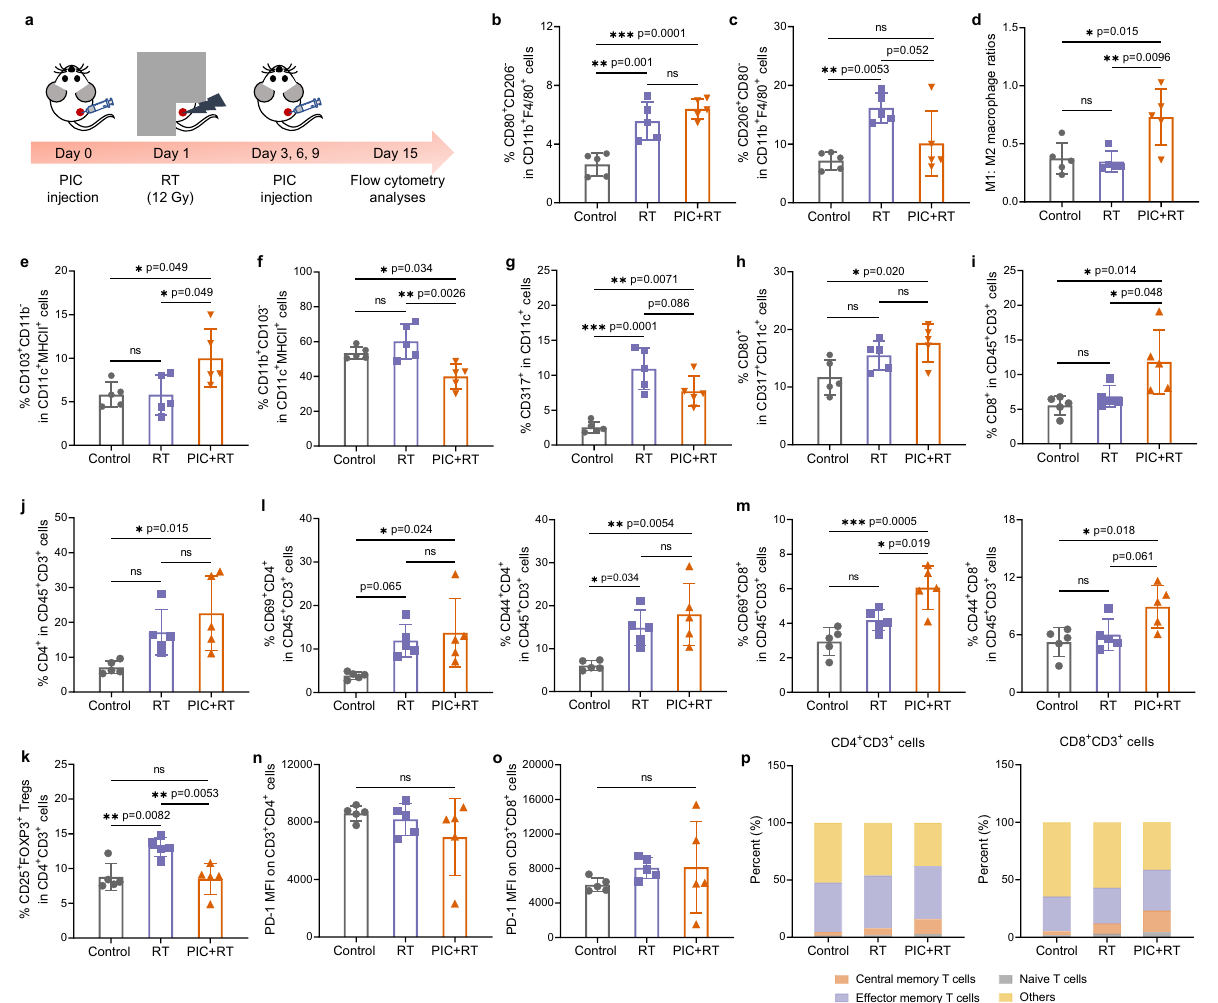
Fig. 4 | The in fl uence of PIC on tumor-in fi ltrating immune cell populations. a Scheme for the studies. The percentage of b CD80 + CD206 − M1-like macrophage and c CD206 + CD80 − M2-like macrophage in CD11b + F4/80 + macrophages in B78 tumors. d The ratios of M1:M2 macrophages in B78 tumors after indicated treat- ments. The percentage of e CD103 + CD11b − cDC1s and f CD11b + CD103 − cDC2s in CD11c + MHCII + DCs inB78tumors. g The percentage of CD317 + pDCsinCD11c + cells in B78 tumors. h The percentage of CD80 + cells in CD317 + CD11c + pDCs in B78 tumors. The percentage of i CD8 + and j CD4 + cells in CD45 + CD3 + T cells in B78 tumors. k The percentage of CD25 + FOXP3 + Tregs in CD4 + T cells in B78 tumors. l The percentage of CD69 + CD4 + and CD44 + CD4 + cells in CD45 + CD3 + T cells in B78